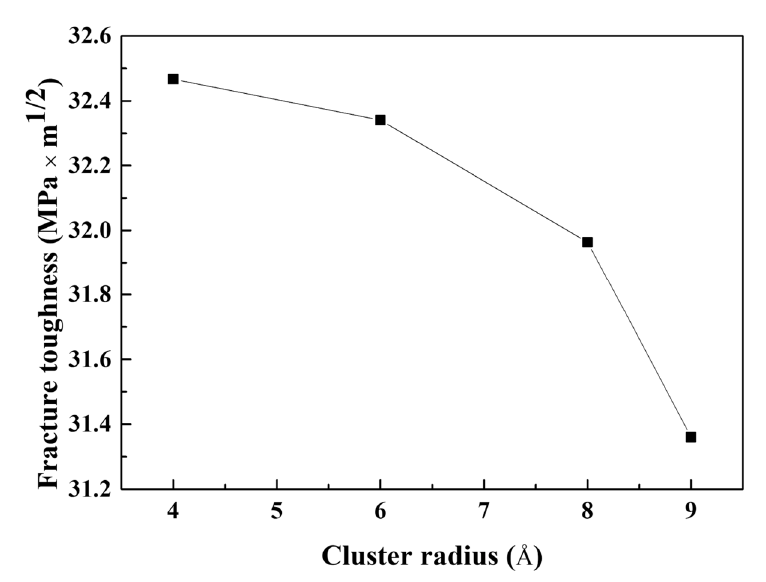
Figure 12. Fracture toughness of the cracked Al containing Mg–Si clusters with radii of 4, 6, 8, and 9 Å as a function of the cluster radius. The fracture toughness was calculated using the empirical equations typically used in experimental measurements.